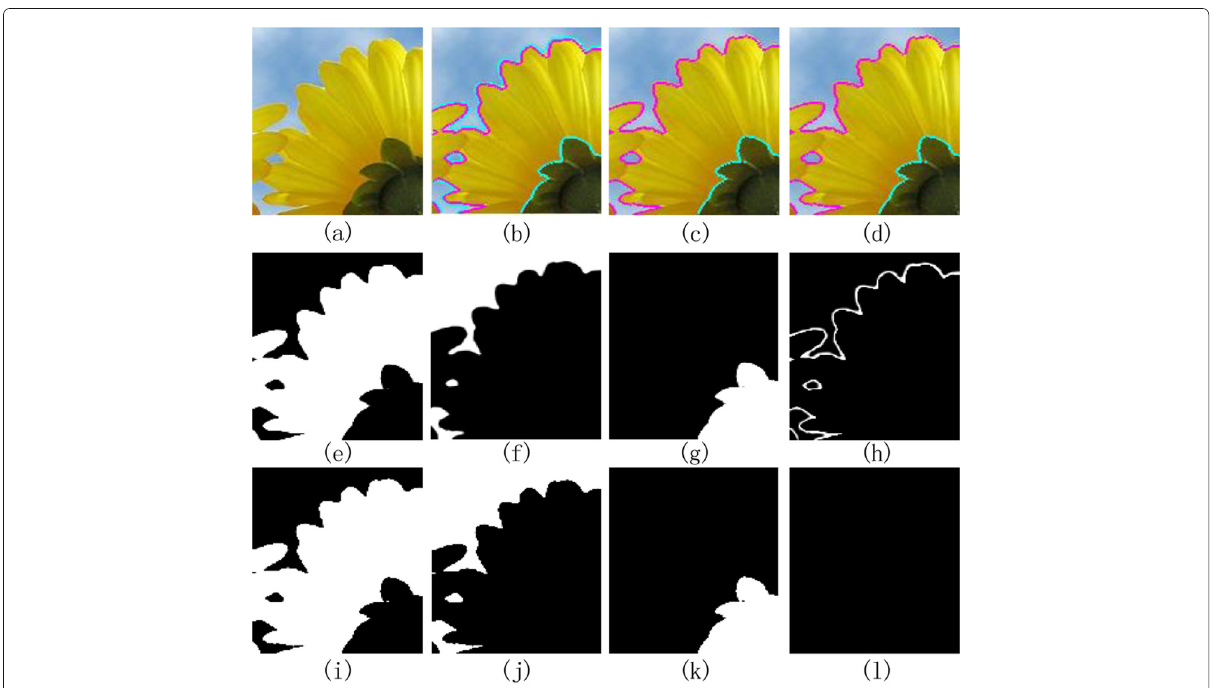
Fig. 9 Three-phase segmentation of a color image. a The input color image. b The segmentation of original Vese-Chan method. c The segmentation of TV regularization method. d The segmentation of our model. e – h Different regions obtained via the original Vese-Chan method. i – l Different regions obtained via our method